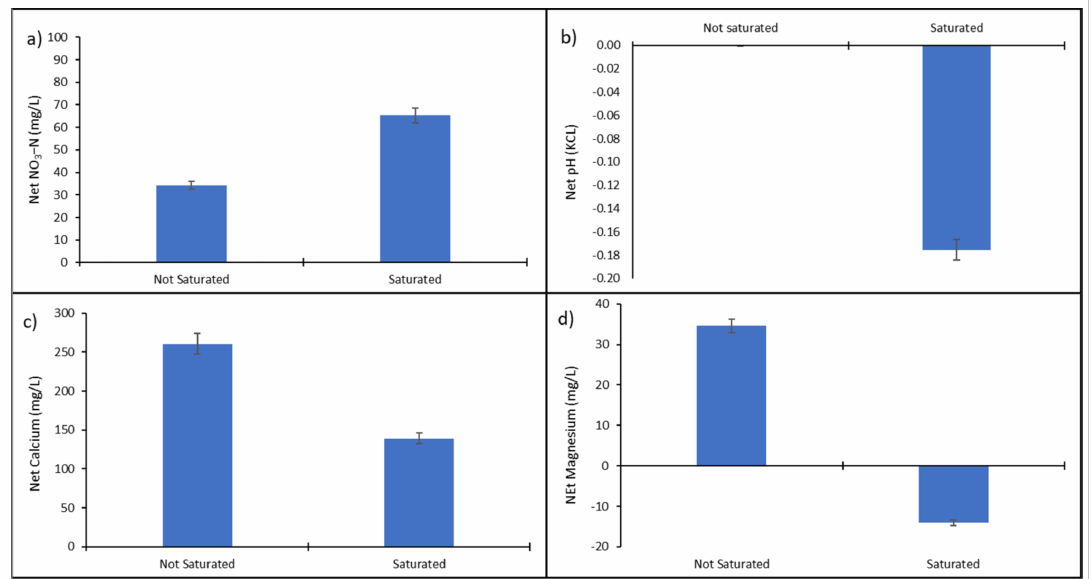
Figure 3. Mean differences in soil properties for saturated vs. not saturated grassland plots across the growing stages, where ( a ) represents net NO 3 − − N concentrations, ( b ) represents changes in acidity (pH), ( c ) represents net calcium concentration (Ca), and ( d ) represents net magnesium concentration